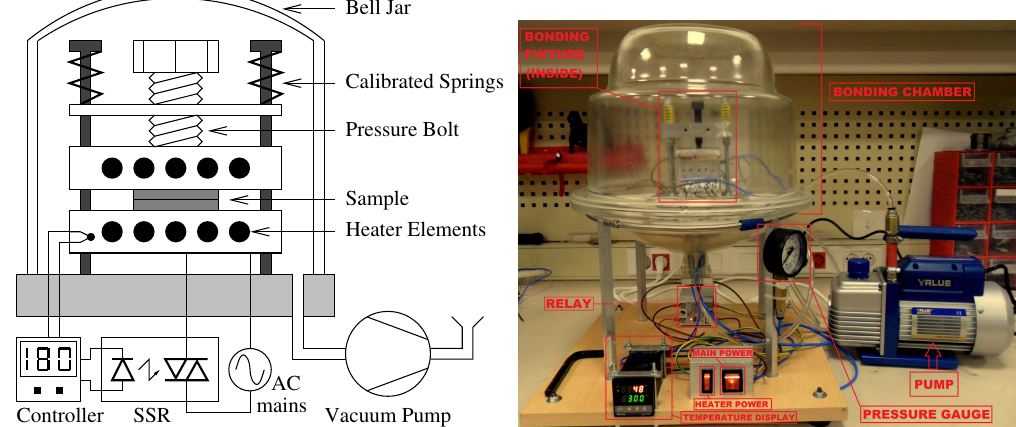
Figure 4. Thermocompression bonding tool: schematic ( left ), and actual ( right